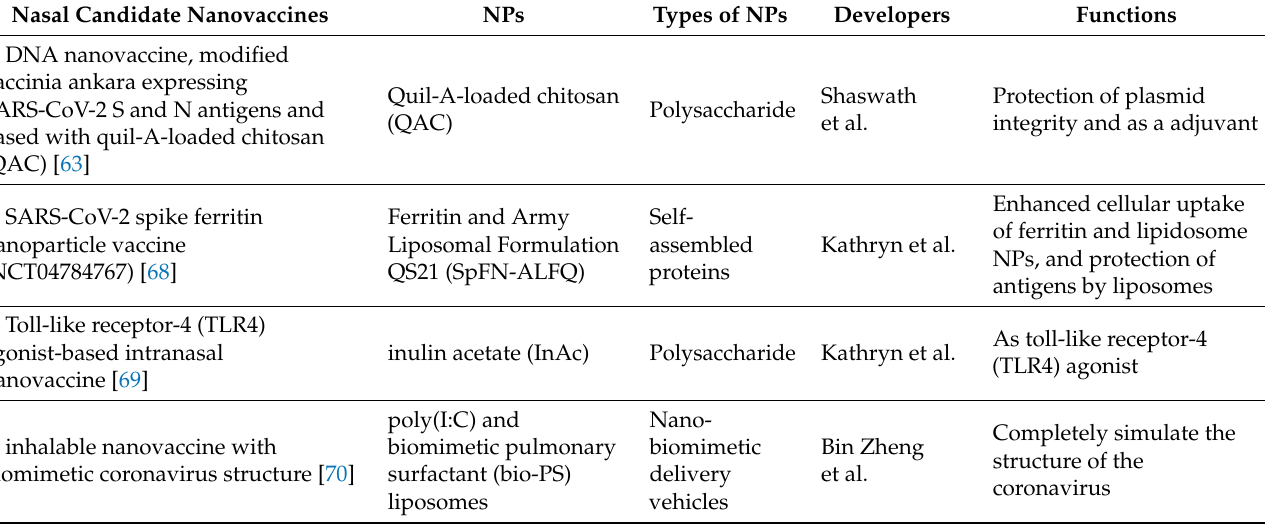
Table 1. Nasal nanovaccines information in